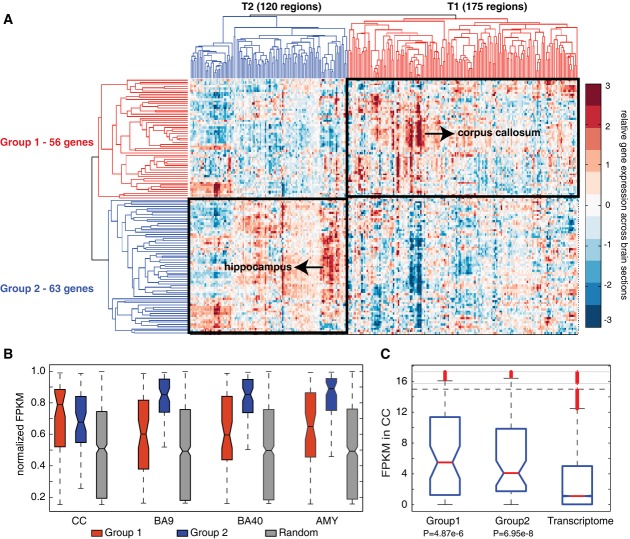
Expression analysis of the synaptic module

Dichotomized expression of the genes in module #13 across 295 brain sections. Relative abundance of each gene across the 295 brain sections was hierarchically clustered to reveal gene groups exhibiting similar expression patterns across tissues. Group 1 genes showed elevated expression in 175 regions (T1, e.g., corpus callosum) relative to other brain sections, and Group 2 genes showed high expression in 120 regions (T2, e.g., hippocampal regions) relative to other brain sections.

RNA-sequencing of four different brain regions from a healthy subject. The brain regions include the Brodmann areas 9 (BA9), 40 (BA40), the amygdala (AMY) and the corpus callosum (CC), which revealed the same observation as from the microarray analyses. Group 1 (red) and 2 (blue) genes were compared with 1,000 randomly sampled genes (gray) from the transcriptome in each brain region. The raw FPKM values were normalized into the cumulative density functions based on kernel density estimation. The elevation of Group 2 genes across all brain regions and the greatest increase of Group 1 genes in the corpus callosum were all statistically significant (P < 1e-5, Wilcoxon rank-sum test).

RNA-sequencing of the corpus callosum transcriptomes from six non-autistic individuals. FPKM quantifies the absolute expression of genes in each group. The two groups have similar expression in the corpus callosum (P > 0.5, Wilcoxon rank-sum test), which are all above the transcriptome background (P < 4.87e-6, Wilcoxon rank-sum test), suggesting that both sub-components are active in this tissue.